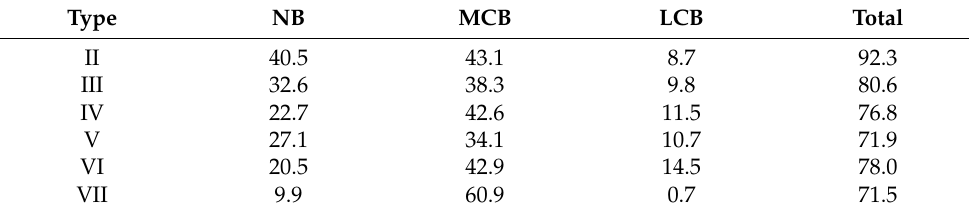
Table 5. Percentage surface areas for each type at navicular bone, medial cuneiform bone, and lateral cuneiform